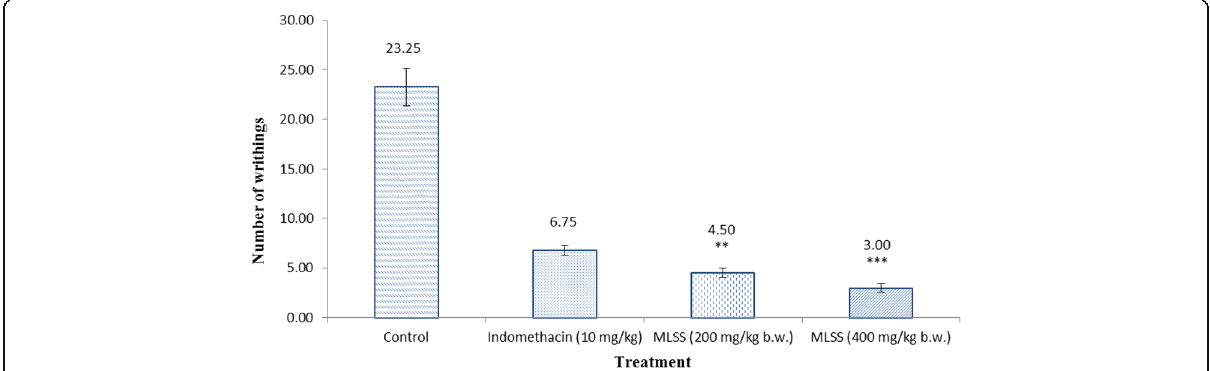
Fig. 1 Effect of L. sativus L. seeds on acetic acid induced writhing in mice. Results are given as mean ± SEM of five animals in each group. ***indicates P < 0.001, **indicates P < 0.01 when compared to control. One-way ANOVA followed by Dunnett ’ s test as compared to control. MLSS = Methanolic extract of L. sativus L. seeds